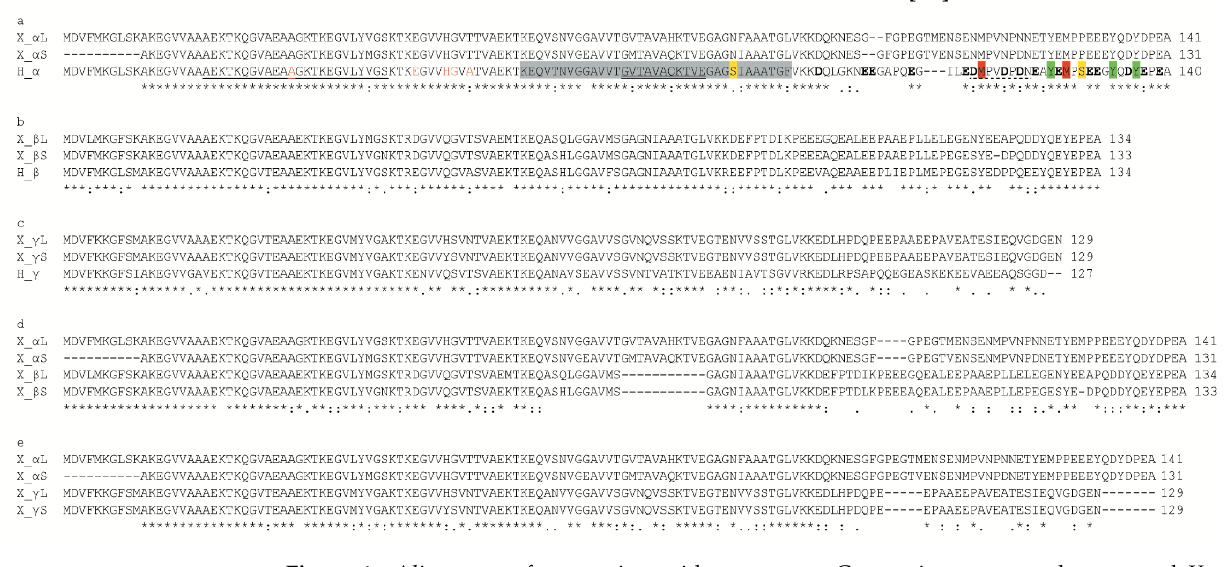
Figure 1. Alignment of syn amino acid sequences. Comparisons among human and Xenopus α - ( a ), β - ( b ) and γ - ( c ) syns, among Xenopus α - and β -syns ( d ), and among α - and γ -syns ( e ). ( a ) Conserved repeats of the apolipoprotein lipid-binding motif [EGS]-KT-K-[EQ]-[GQ]-V-XXXX are underlined. The non-amyloid-component (NAC) region of α -syn, the phosphorylatabletyrosines and serines are highlighted in grey, green and yellow, respectively. The methionines representing binding sites for Mn(II) and other metals are highlighted in red. Negative amino acids in the CT region are indicated in bold. The amino acids that in humans are involved in the pathological mutations linked to Parkinson’s disease are shown in red. The aa stretch GVTAVAQKTVE that is directly involved in the formation of human amyloid fibrils is double underlined. The sequences were aligned with Clustal Omega. Asterisks indicate identity of amino acids; double dots indicate amino acids with the same polarity or size; dots indicate semiconserved substitutions. The epitope recognized by the ab27766 antibody is dotted underlined.